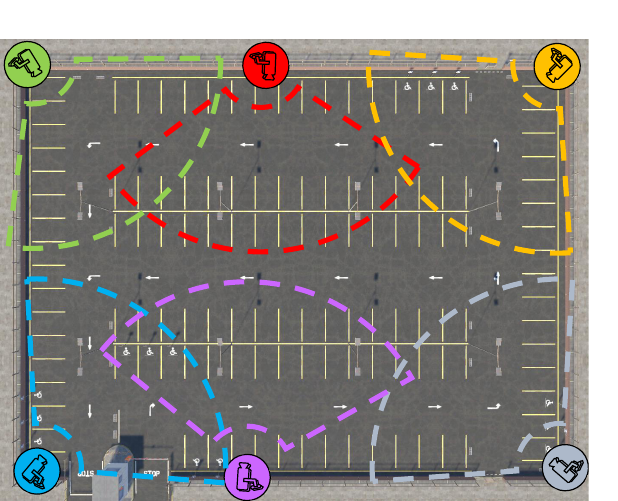
( d ) Aerial view of the 3D parking lot model with camera positions.